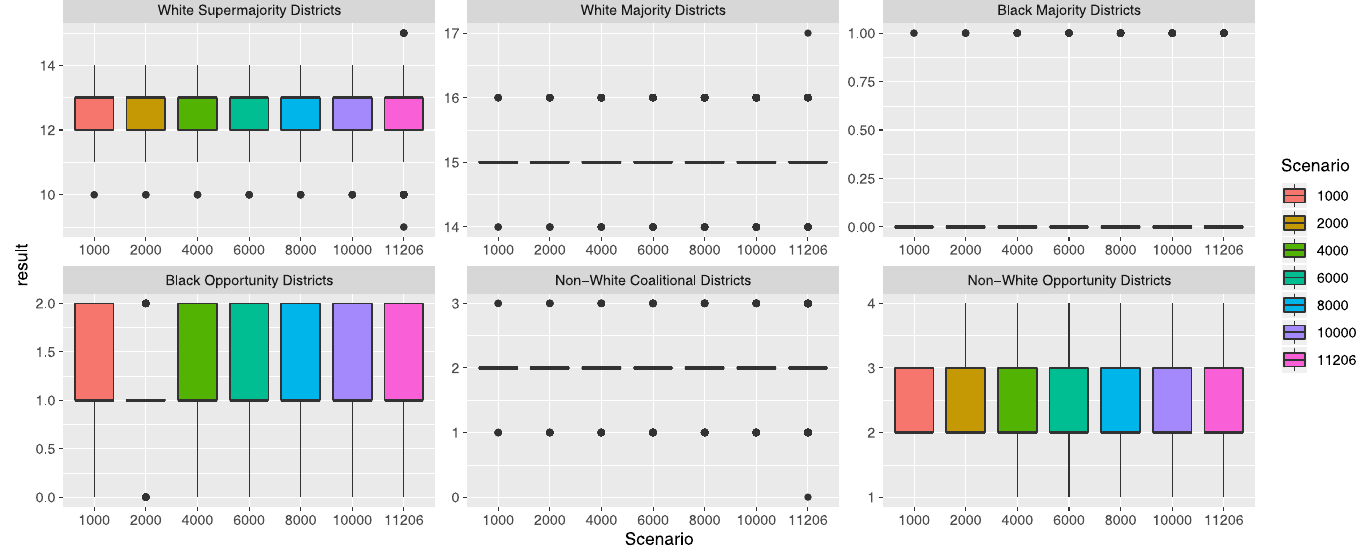
Fig 7. Minority majority metrics for different numbers of calculated solutions.